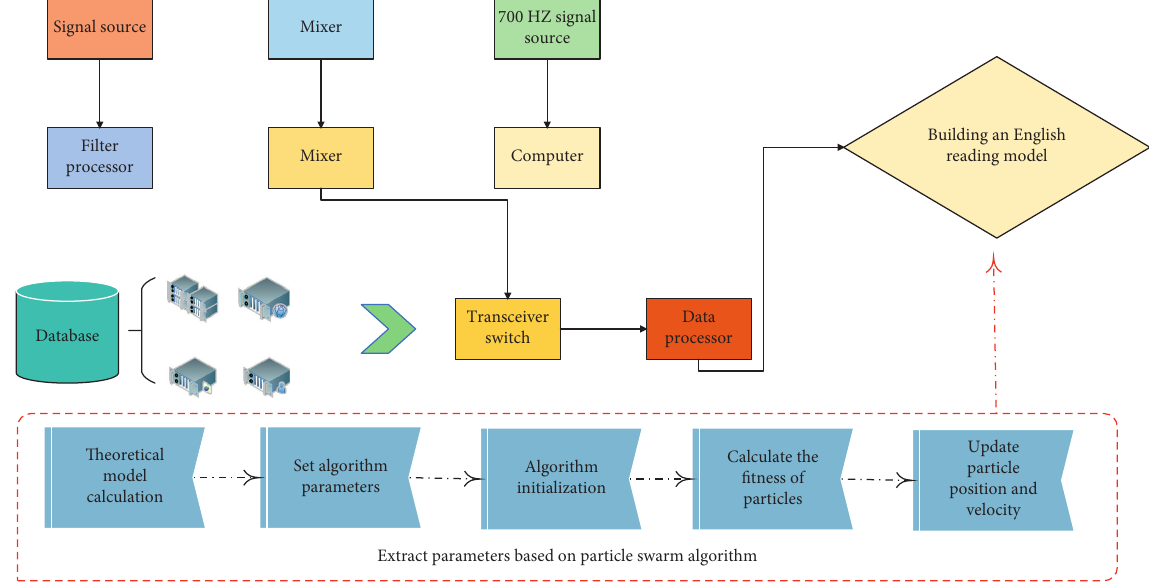
Figure 2: Array passive wireless sensing system composition.